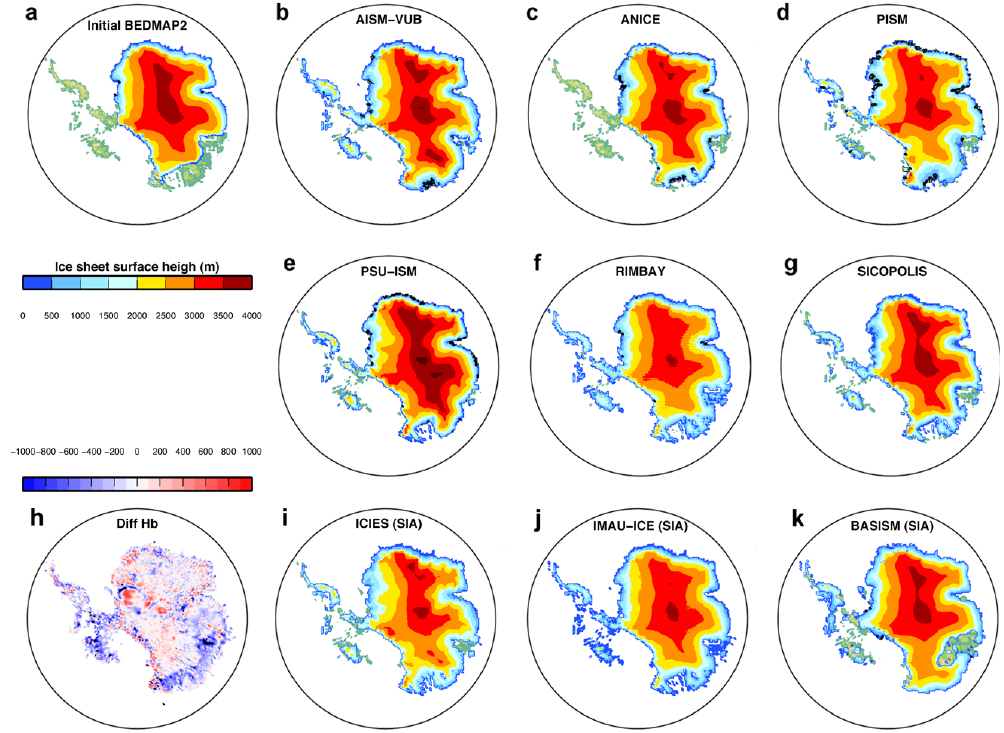
Figure 11. Ice surface topography and ice thickness of the ice shelves for the Pliocene Ice-PRISM3 simulation with Bedmap2. (a) The initial PRISM3 ice sheet topography modified for Bedmap2 (see text for details). (b) AISM, (c) ANICE, (d) PISM, (e) PSU-ISM, (f) RIMBAY, (g) SICOPOLIS. (h) Difference between Bedmap2 and Bedmap1 bedrock topography for the PRISM3 initial ice sheet. SIA-only models; (i) IcIES, (j) IMAU-ICE, (k)